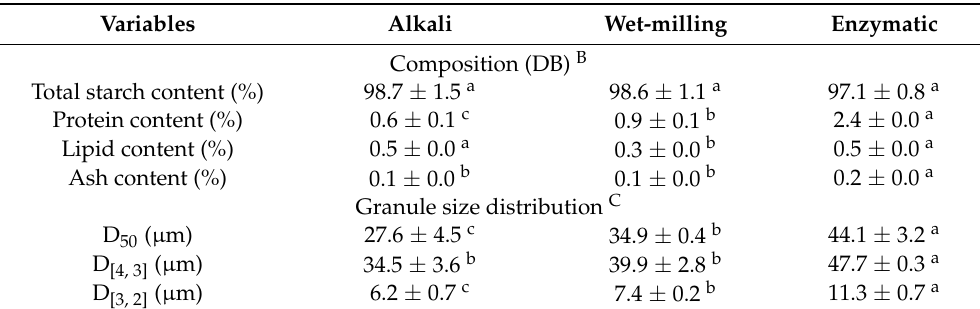
Table 1. Proximate composition and particle size of quinoa starch isolated by three different methods (alkali, wet-milling, and enzymatic) A